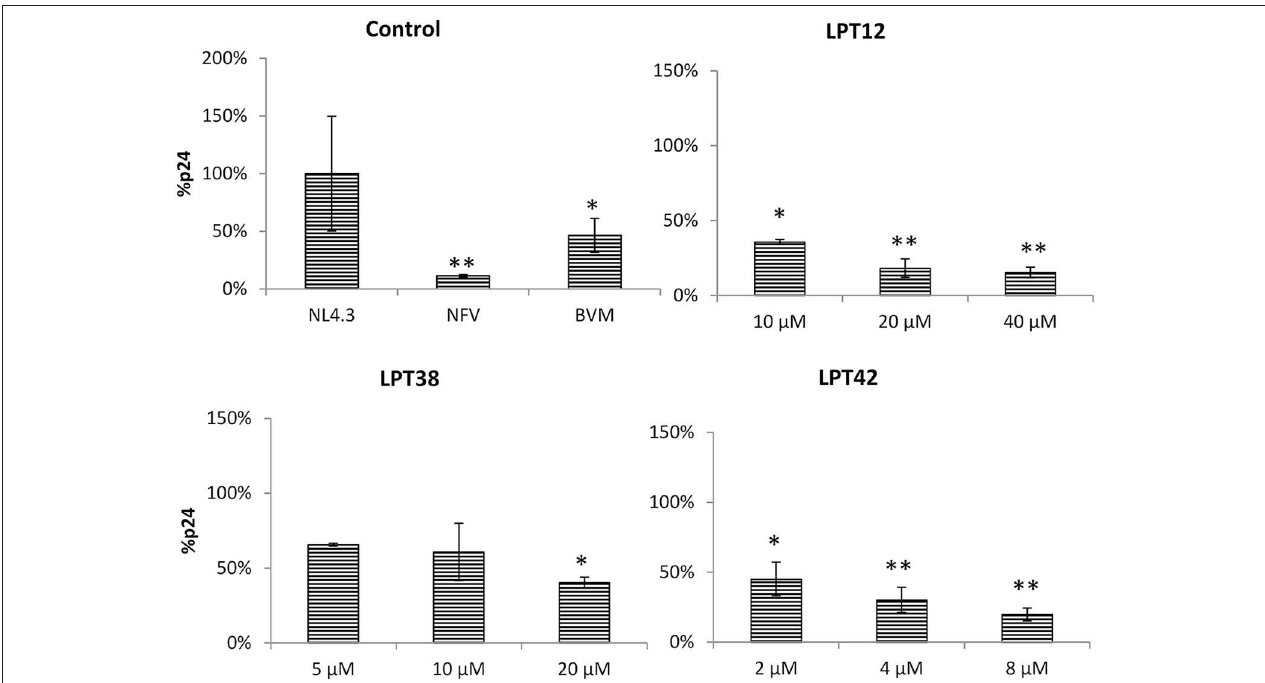
FIGURE 6 | Inhibition of HIV-1 (NL4.3) Gag production in 293T cells by LPT12, LPT38, LPT42, Nelfinavir 0.1 µ M (NVF), and Bevirimat 0.1 µ M (BVM). p24 Gag protein were detected by an ELISA Elecsys system (Roche). Results are shown as percentage of Gag-p24 protein as compared to an untreated control (100%). ANOVA analysis was performed to determine the value of p (* p < 0.05, ** p < 0.01) and NL4.3 (untreated HIV-1 transfection) was used as